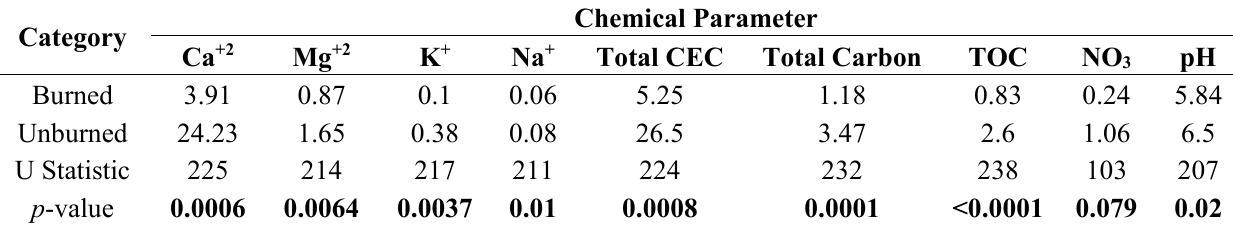
Table 7. Wilcoxon rank sum test results with medians in cmol·kg − 1 for Ca +2 , Mg +2 , K +1